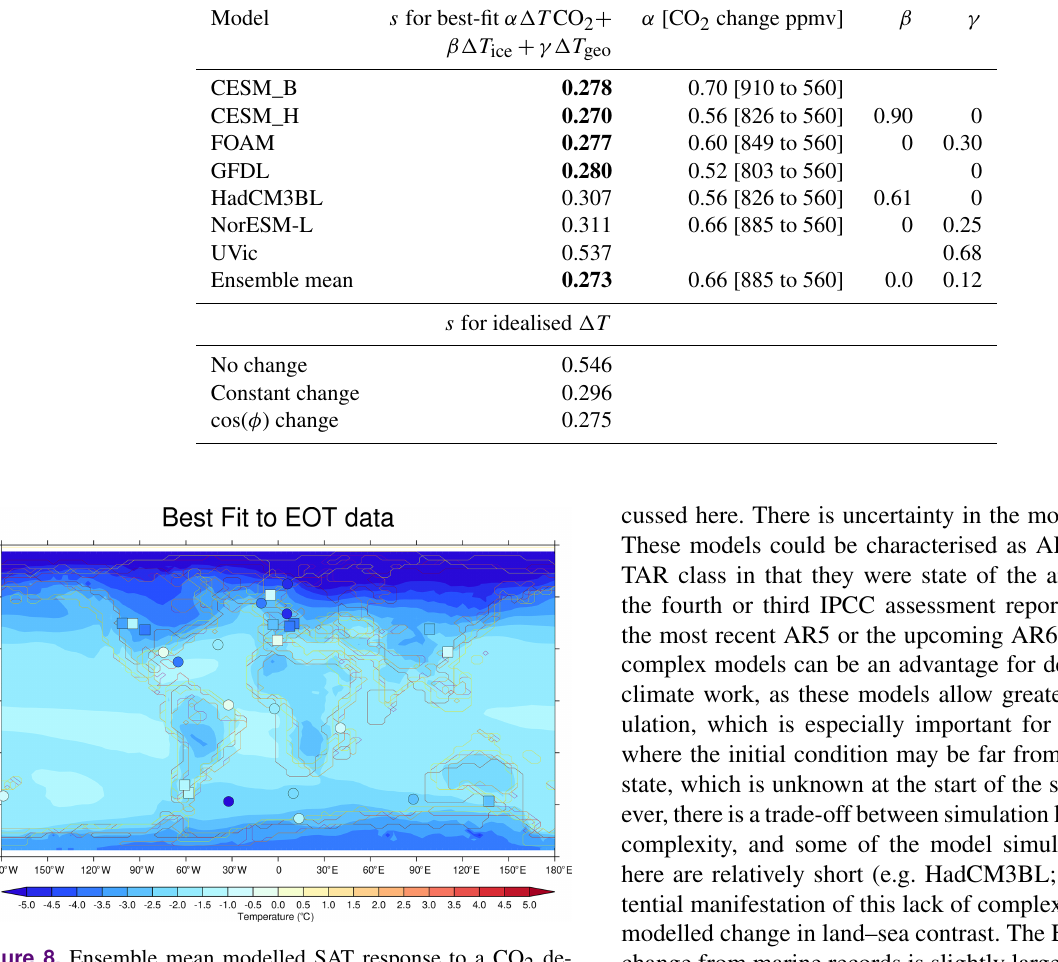
Figure 8. Ensemble mean modelled SAT response to a CO 2 de- crease from 885 to 560ppmv, representing the best fit to the proxy data. The marine proxy data are shown as filled circles, while the terrestrial proxy data are shown as filled squares. Coastlines from each model are plotted to illustrate the uncertainties associated with the palaeogeographic